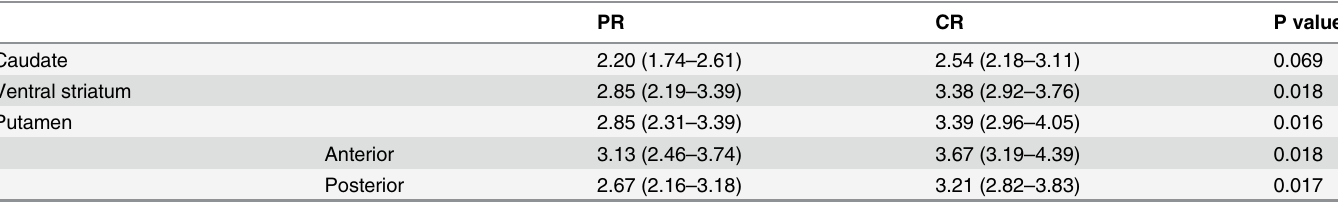
Table 4. The 18 F-FP-CIT uptake in striatal